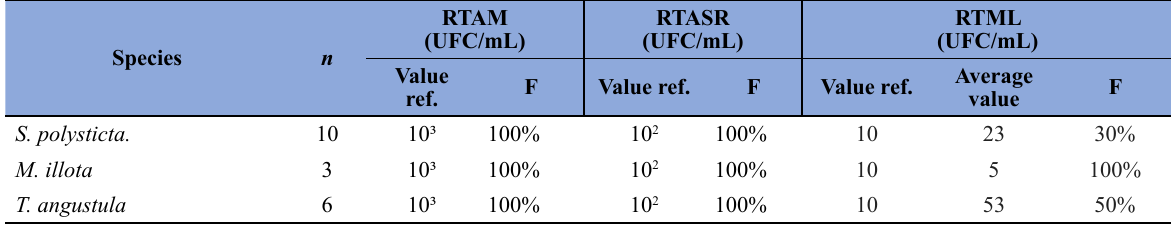
Table 5. Frequency of samples (F) that meet the legal standards of microbiological quality of honey from three species of stingless bees: S. polysticta, M. illota and T.